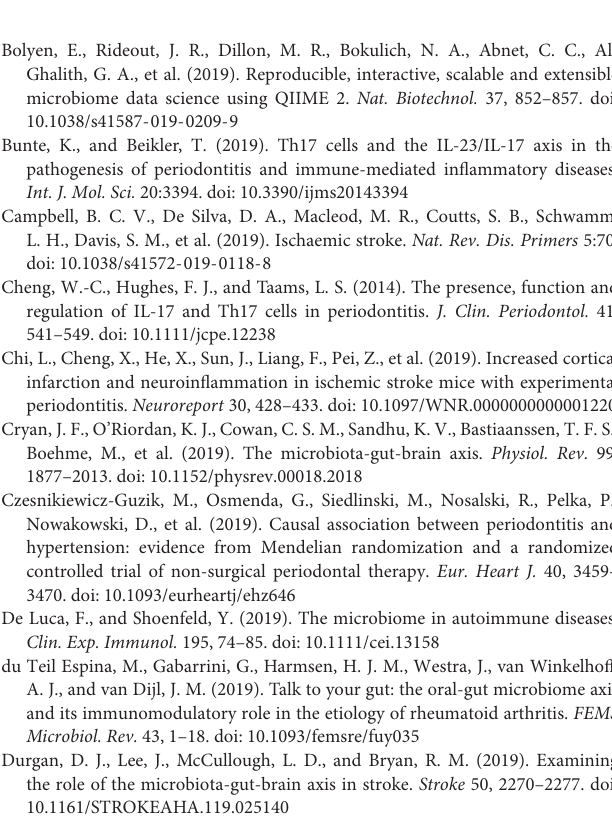
Supplementary Figure 5 | Gavage of salivary microbiota of periodontitis patients does not affect Th17 cells or IL17 + γδ T cells in mouse colons after ischemic stroke. (A) Left, representative flow cytometry analysis of CD4 + IL-17A + cells (Th17 cells) in the colon. Right, quantification of Th17 cells. n = 5:5:6:6. (B) Left, representative flow cytometry analysis of TCR- γδ + IL-17A + cells (IL-17 + γδ T cells) in the colon. Right, quantification of IL-17 + γδ T cells. n = 5:5:5:5. (C) Left, representative flow cytometry analysis of CD4 + ROR γ t + T cells in the colon. Right, quantification of CD4 + ROR γ t + cells. n = 6:6:6:6. (D) Left, representative flow cytometry analysis of TCR- γδ + ROR γ t + cells in the colon. Right, quantification TCR- γδ + ROR γ t + cells. n = 5:5:5:5. Values represent mean ± SD . One-Way ANOVA was used for statistical analysis. ns, not significant. Supplementary Figure 6 | (A) Experimental design for testing the effects of saliva of periodontitis patients without MCAO. (B) Increasing of Th17 and IL-17 + γδ T cells in the small intestine didn’t require MCAO operation. Left, quantification of Th17 cells. n = 5: 6: 6 Right, quantification of IL-17 + γδ T cells. n = 5: 5: 5. (C) Gavage of salivary microbiota of periodontitis patients does not affect CD4 + Foxp3 + cells in the small intestine of mice after ischemic stroke. Representative flow cytometry analysis of CD4 + Foxp3 + cells. (D) Quantification of CD4 + Foxp3 + cells in (C) . n = 6:6:6:6. Values represent mean ± SD . One-Way ANOVA was used for statistical analysis. ns, not significant. ∗ p < 0.05, ∗∗ p < 0.01, ∗∗∗ p < 0.001. Supplementary Figure 7 | Flow cytometry analysis of CD11c + MHCII + cells and CD11b + CD64 + cells. MCAO does not affect dendritic cells or macrophage cells in the small intestine of mice after ischemic stroke. And macrophages do not migrate from the small intestine to the brain after ischemic stroke. (A) Representative flow cytometry analysis of CD11c + MHCII + cells and CD11b + CD64 + cells in the small intestine. (B) Quantification of CD11c + MHCII + cells and CD11b + CD64 + cells. n = 5: 4. (C) Representative flow cytometry analysis of KaedeR + CD11b + CD64 + macrophages in the brain of mice 1 day after MCAO or sham operation. Values represent mean ± SD . Student’s t -test was used for statistical analysis. ns, not